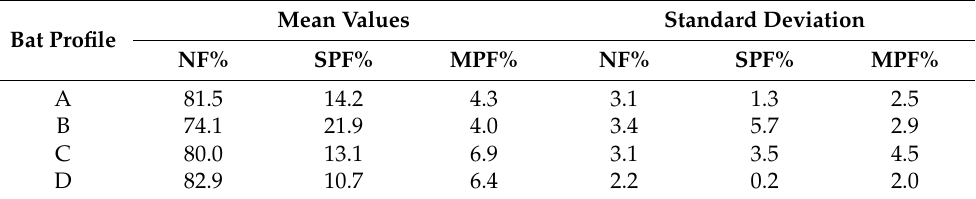
Table 2. Summarized Probability Analysis Results for Centerline